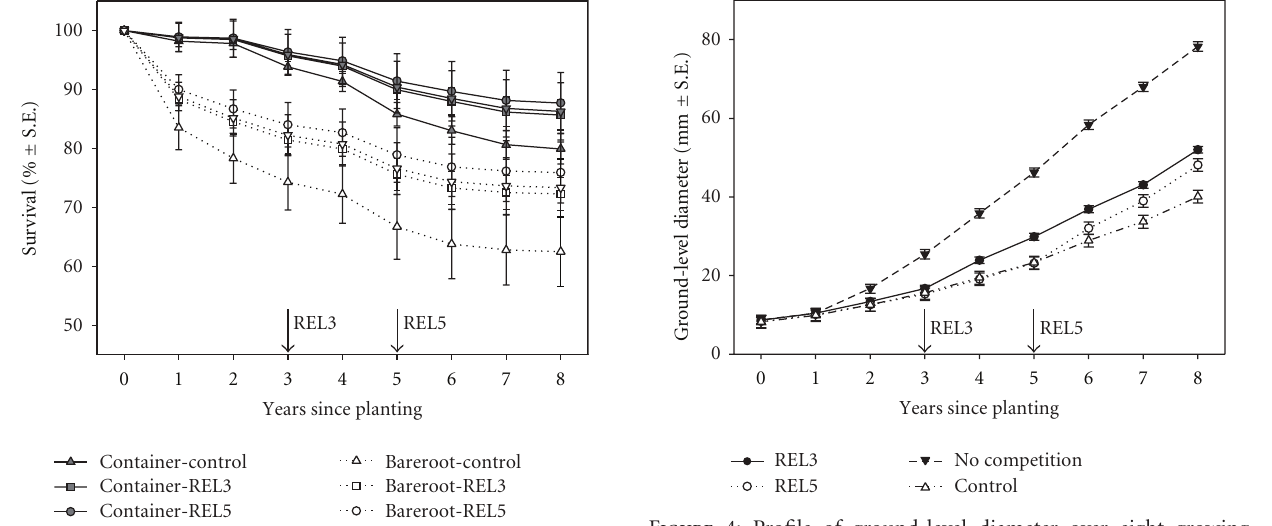
Figure 4: Profile of ground-level diameter over eight growing seasons, for large containerized and bareroot Picea glauca seedlings outplanted in south central Quebec (Canada). Treatments consisted of four intensities of vegetation management, including a control, mechanical release during the third growing season (REL3), me- chanical release during the fifth growing season (REL5), and plots where competition for light was eliminated through repeated her- bicide and mechanical release treatments (No competition: